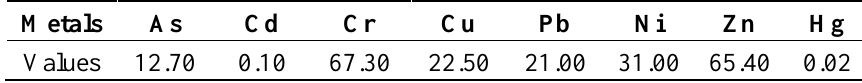
Table 1. Geochemical background value